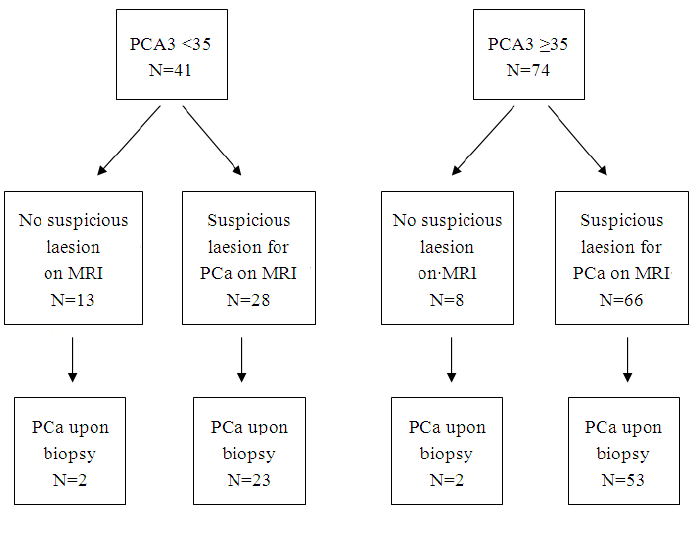
Figure 1. Flow diagram of the 115 patients that had a PCA3 test, multiparametric MRI and prostate